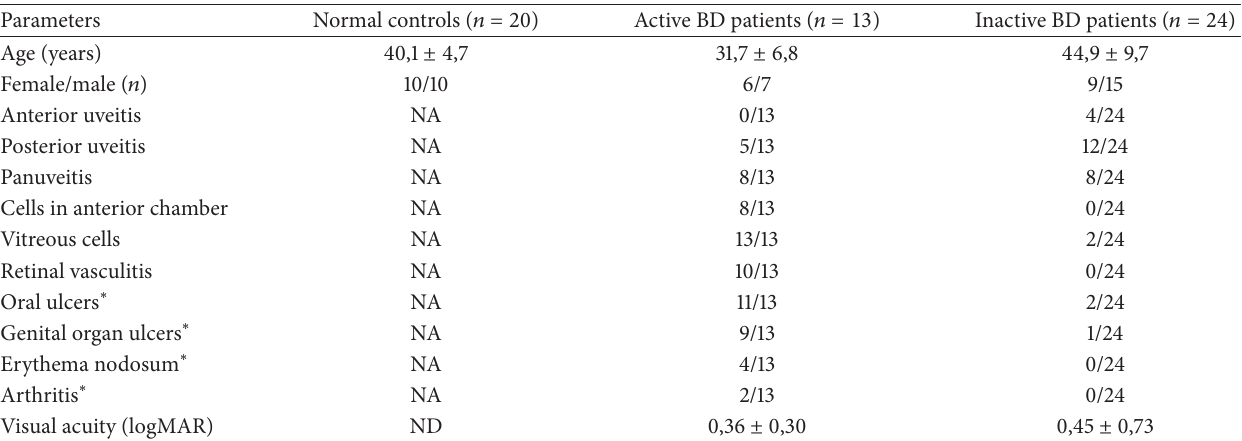
Table 1: Clinical characteristics of BD patients and normal